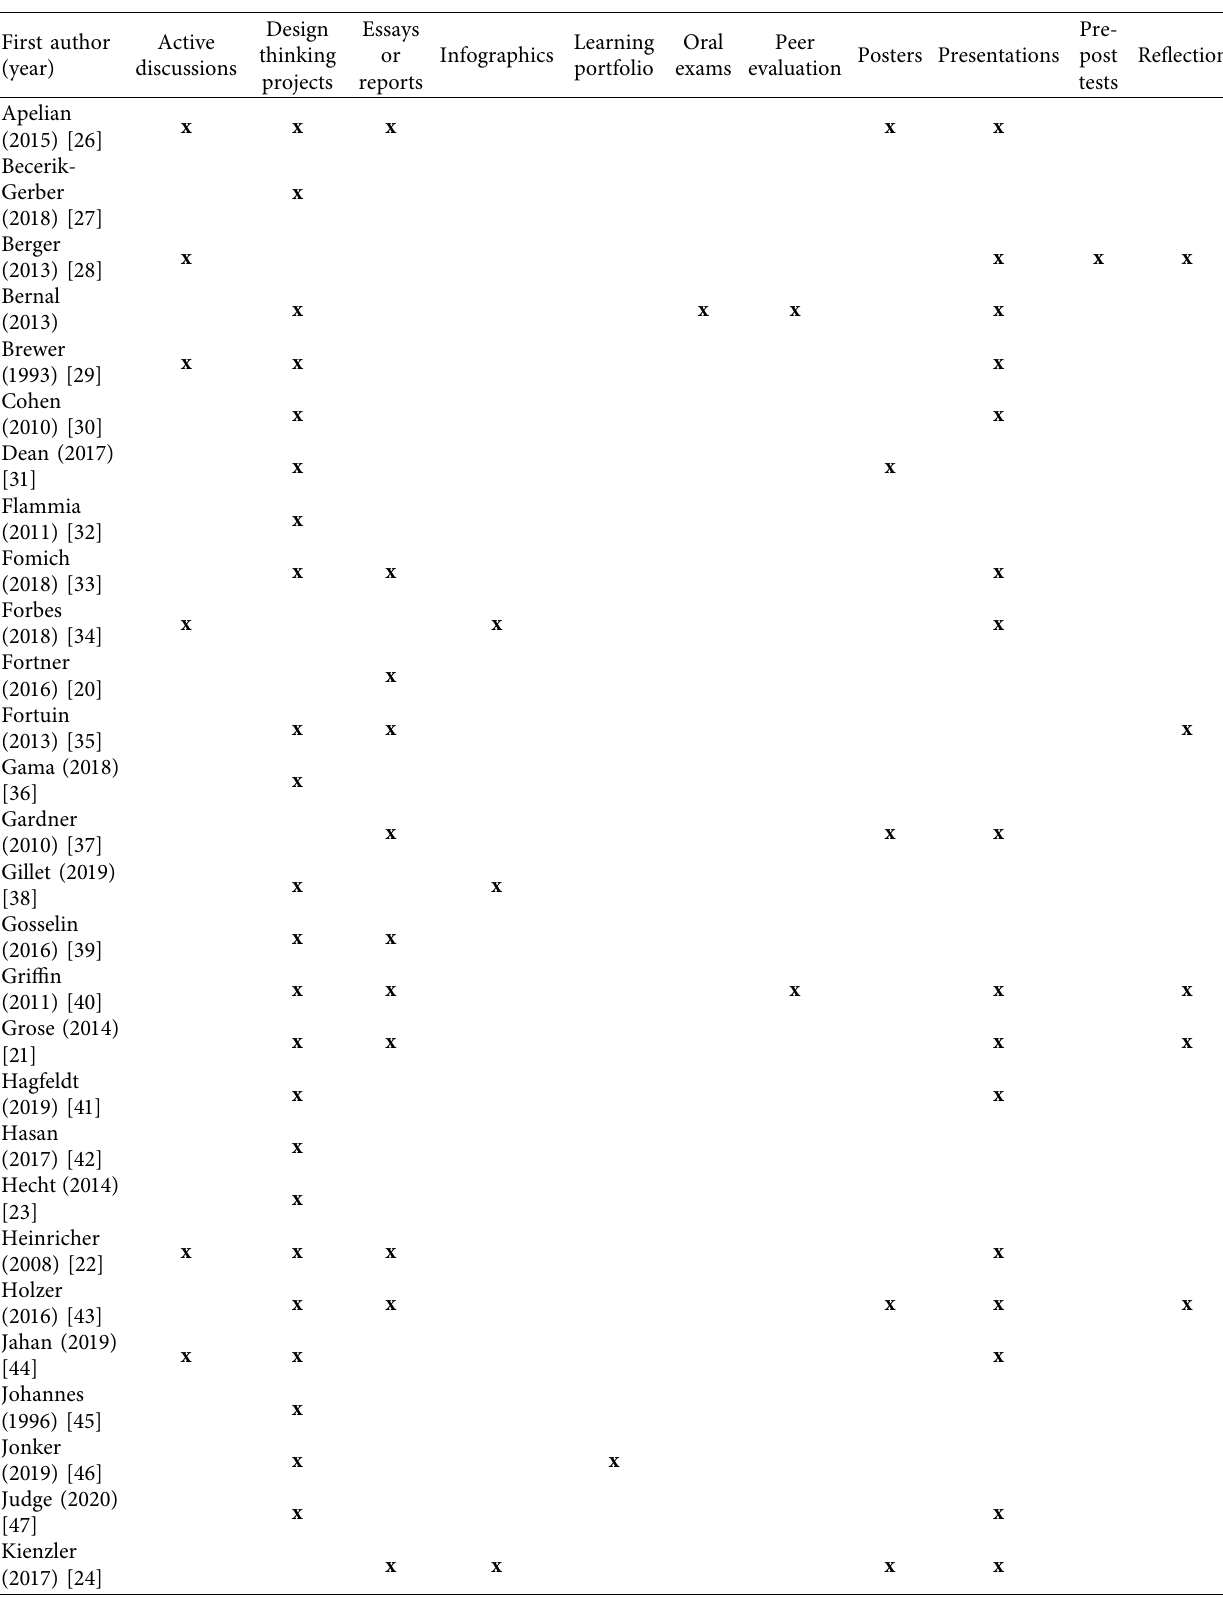
Table 4: Grand challenge course